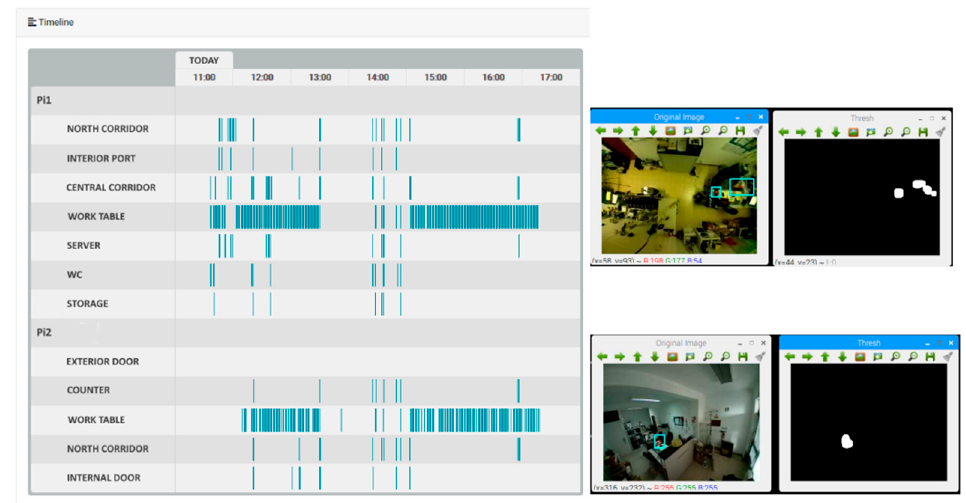
Figure 15. Timeline of events and the respective devices.